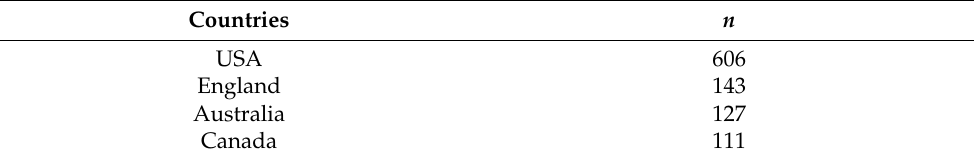
Table 8. Most productive countries.